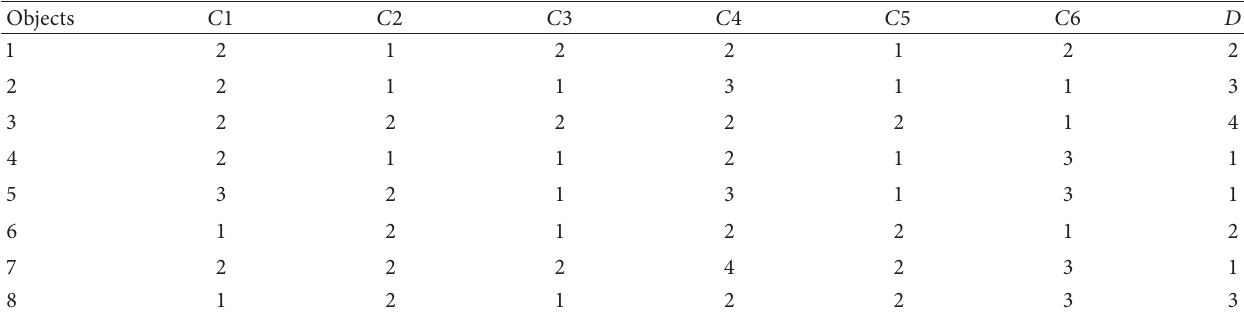
Table 3: An example of decision table with eight objects.